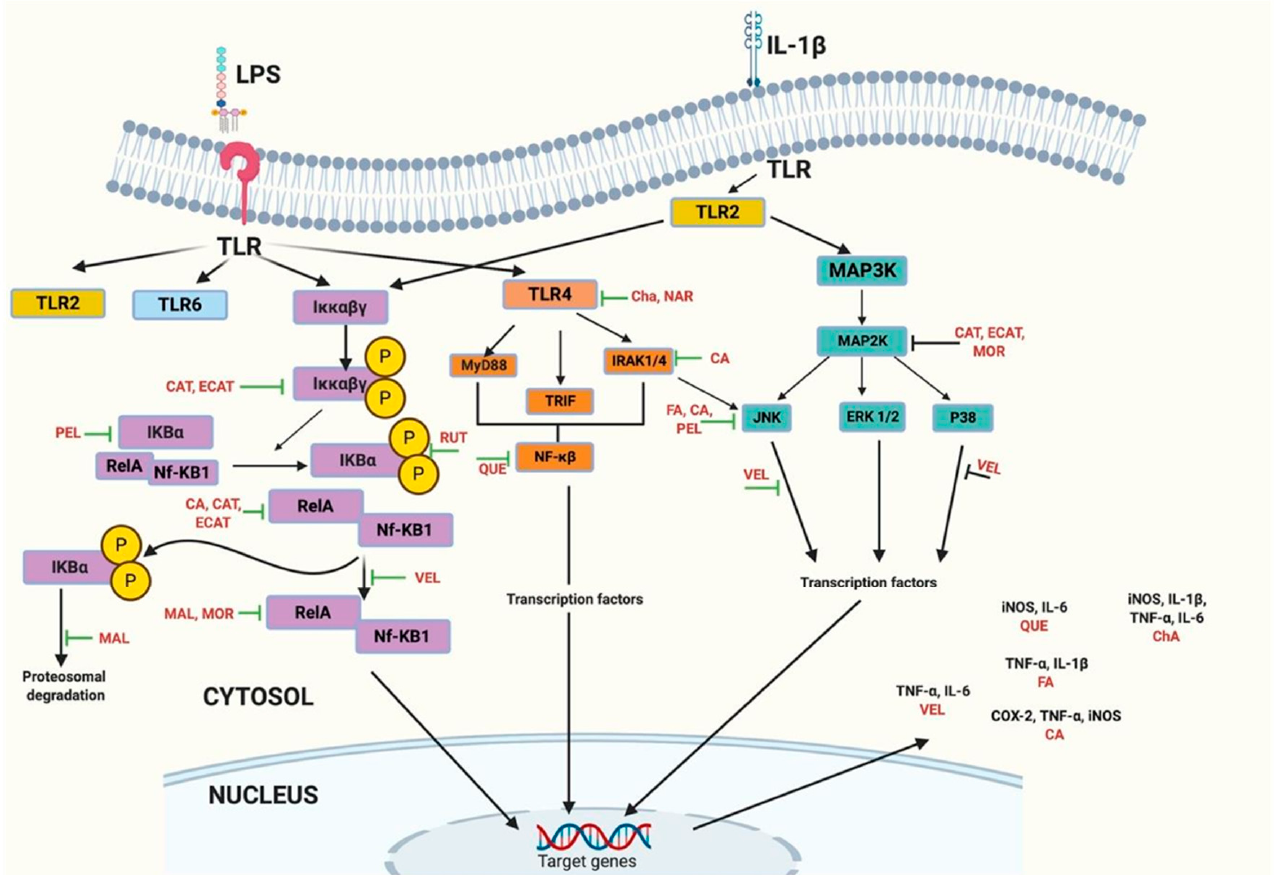
Figure 2. Mechanism of action of some phenolic compounds found in lesser-consumed tropical fruits (lychee, mamey, passion fruit, açaí and jackfruit) and their ability to regulate the inflammatory process. Phenolic compounds can inhibit pro-inflammatory mediators such as IL-6, iNOS, IL-1 β , TNF- α , COX-1, COX-2 by inhibiting their activity or gene expression. In addition, some phenolic compounds can up/downregulate transcriptional factors, such as nuclear factor- κ B (NF- κ B) or Nrf-2, in inflammatory and antioxidant pathways. PEL: pelargonidine; CAT: catechin; ECAT: epicatechin; CA: caffeic acid; MOR: moracin; MAL: malvidin; VEL: velutin; RUT: rutin; QUE: quercetin; Cha: chlorogenic acid; NAR: naringenin; FA: ferulic acid.